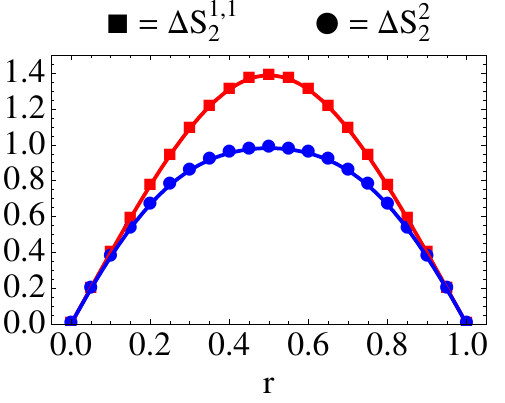
Figure 5 . Comparison between analytic results (continuous curves) and numerical values (dots) of the R(cid:19)enyi entropies for two particle states with equal and distinct momenta. We show the 2nd R(cid:19)enyi entropies with distinct momenta given by P 1 (cid:25) 30 ; P 2 (cid:25) 45 (squares, red curve) and with equal momenta P 1 = P 2 (cid:25) 50 (dots, blue curve). Additional choices of the momenta are explored in tables 1 and